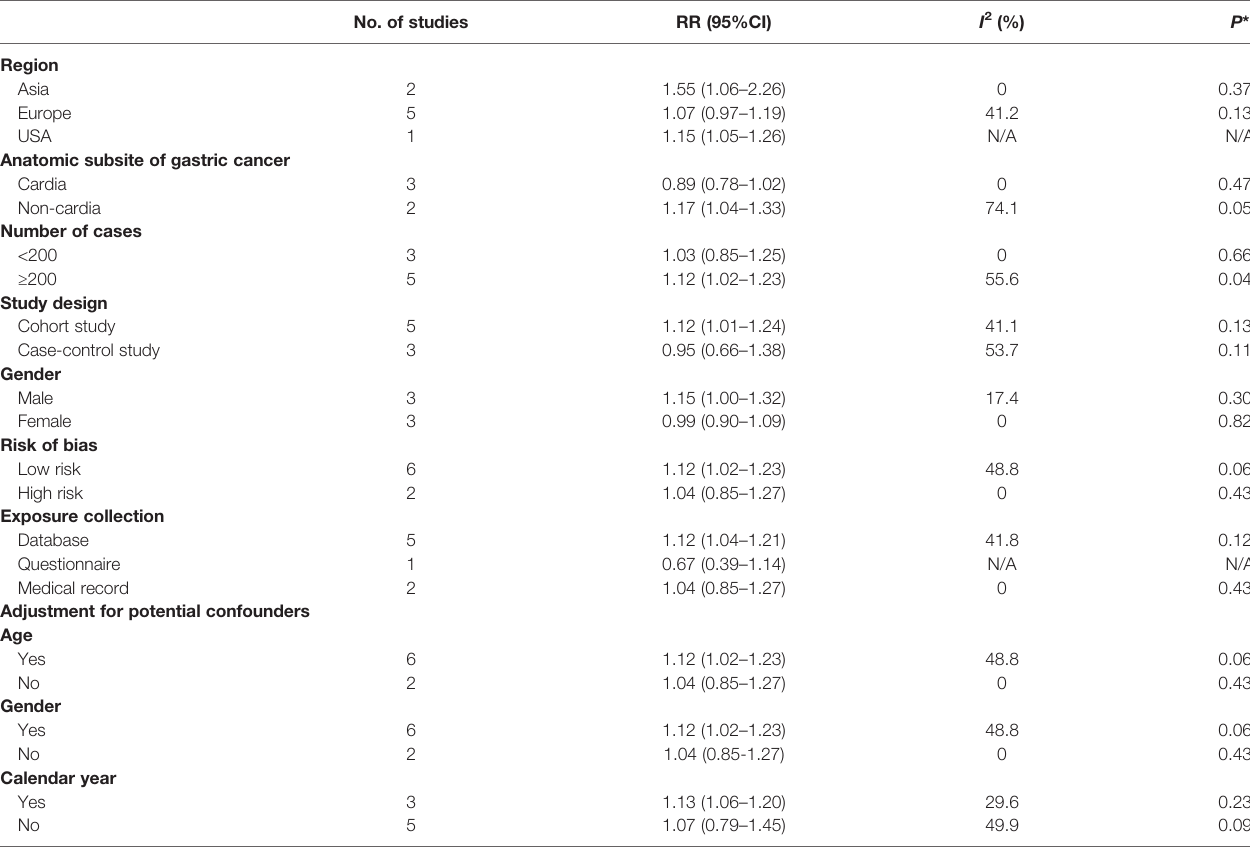
TABLE 2 | Risk estimates for cholecystectomy associated with gastric cancer in subgroup